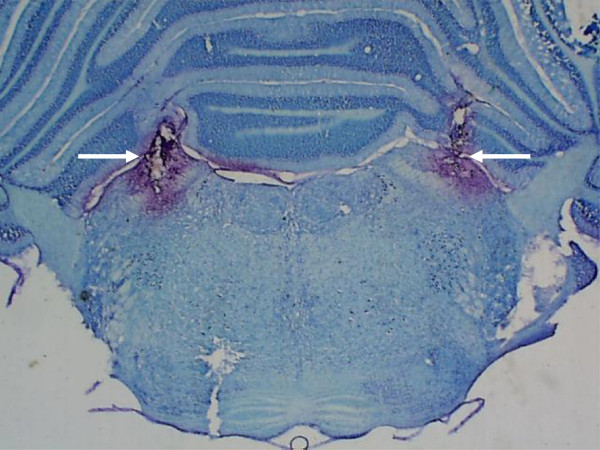
Photomicrograph showing the sites of injections into the LPBN (arrows).